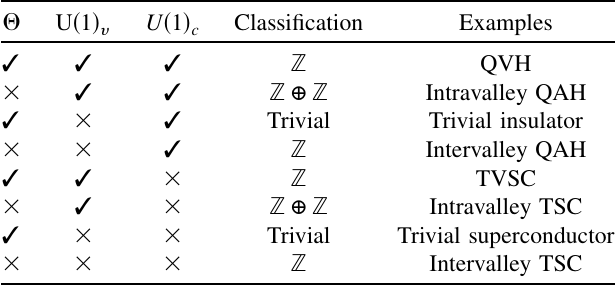
TABLE I. Classification of the SPT on multilayer graphene by considering the presence ( ✓ ) or absence ( (cid:5) ) of the time-reversal , valley-polarization conservation U ð 1 Þ symmetry ^(cid:2) / i(cid:4) y charge conservation U ð 1 Þ . Four upper rows classify topological c insulators, while four lower rows classify TSCs.